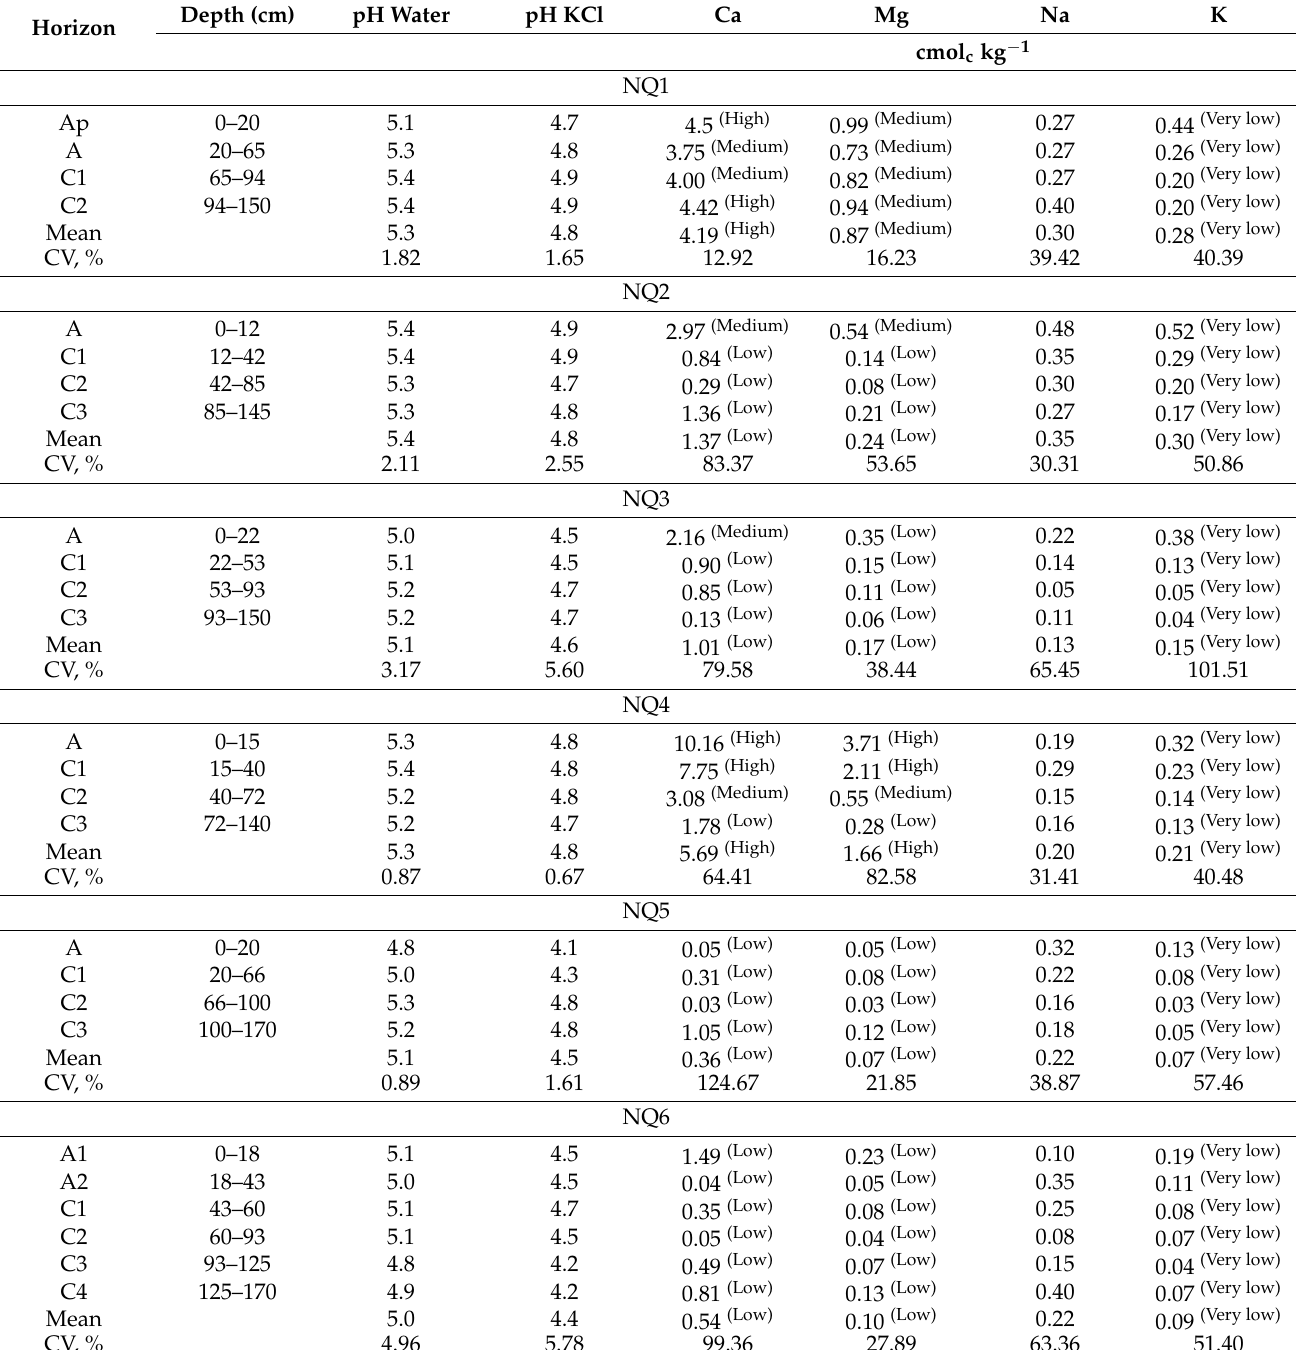
Table 5. Mean values of chemical parameters and interpretation * of Quartzipsamments profiles of the Southwest of Rio Grande do Sul State, southern